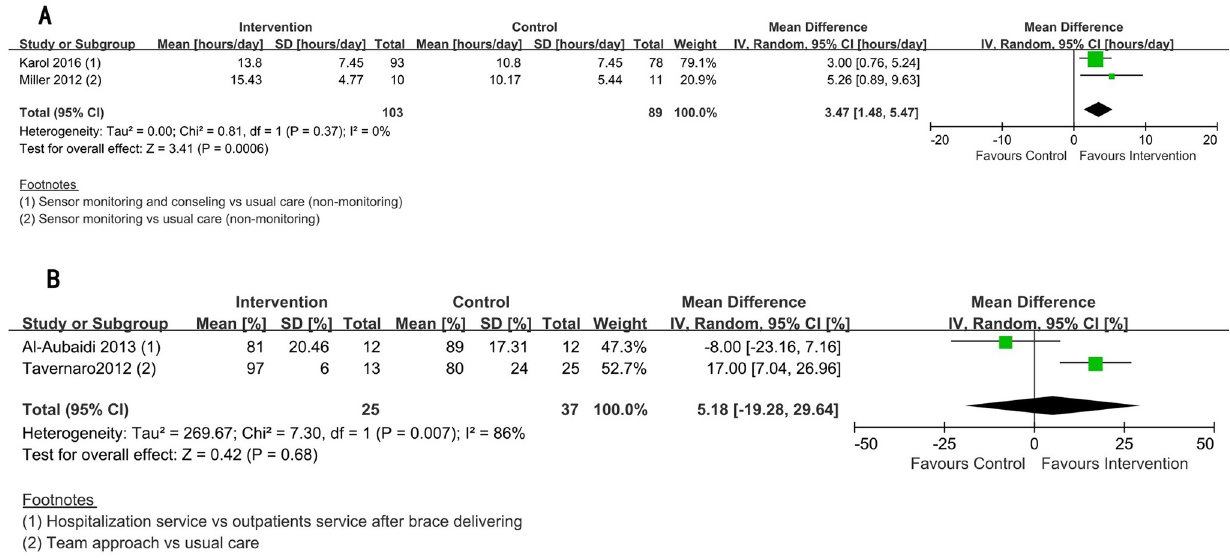
Fig 5. Forest plot of mean differences (with 95% confidence intervals) and study weights for studies with similar interventions (sensor monitoring intervention, and medical care intervention).